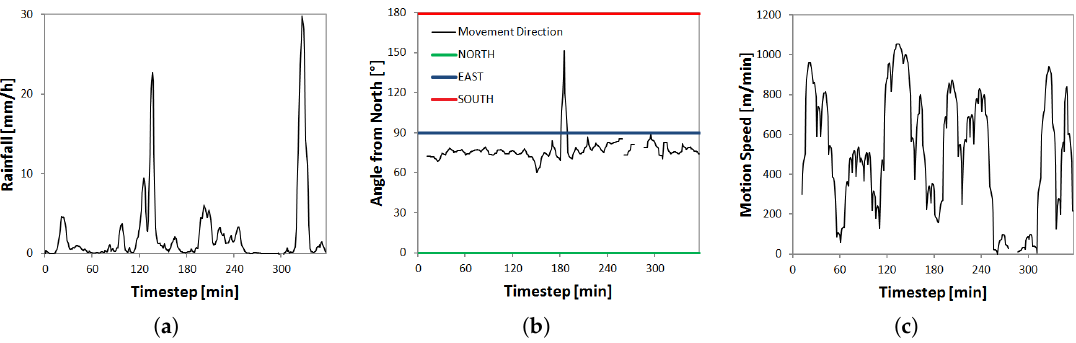
Figure 8. Characterization of the radar event. ( a ) Time series of radar estimated rainfall averaged over the study area; ( b ) time series of mean motion direction calculated by image-based optical flow; ( c ) time series of the mean motion speed calculated by optical flow. Time steps of no data values result from the inability of the optical flow (OF) algorithm to detect field motion when there is no rainfall.